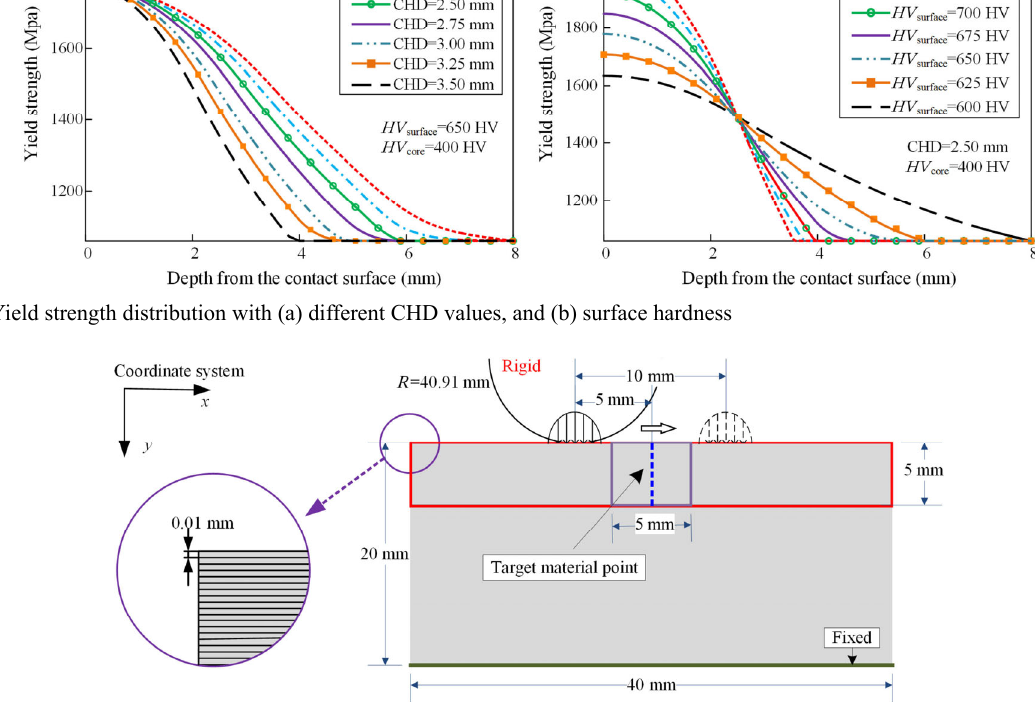
Fig. 7 Finite element elastic-plastic contact